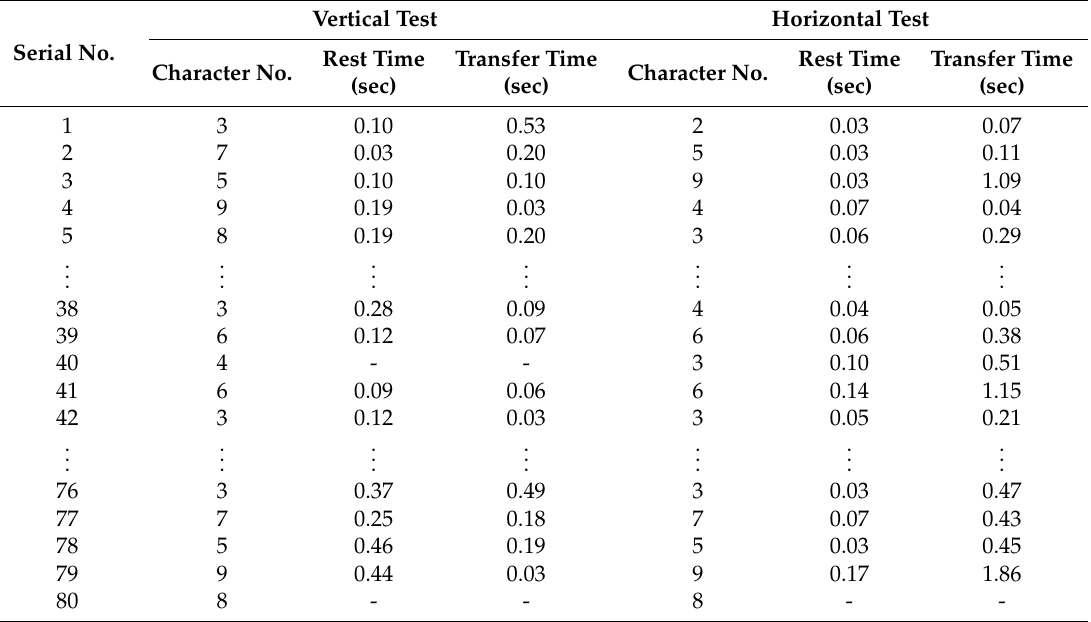
Table 3. A sample of the logs of the rest times and transfer times of the vertical test and the horizontal